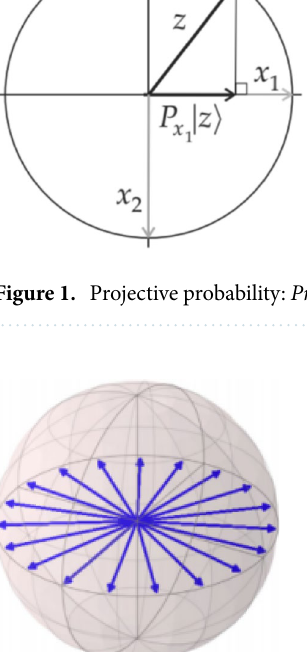
Figure 2. Representation of the pure state (root